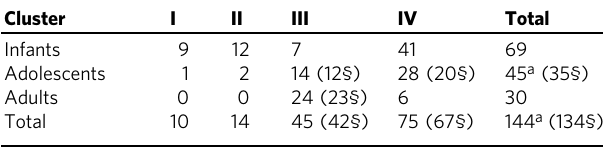
Table 1 Details of major clusters